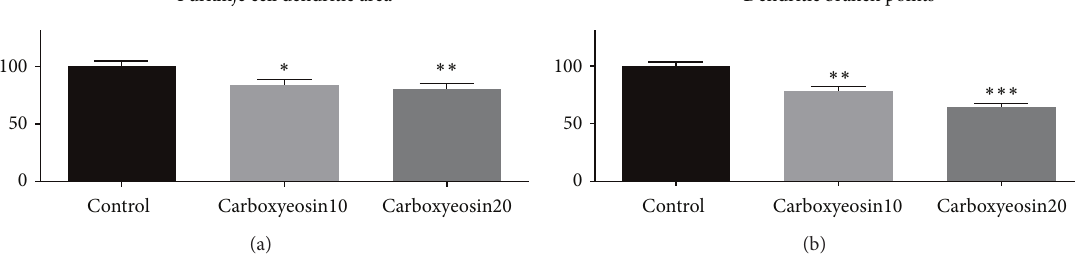
Figure 2: (a) Size of Purkinje cell dendritic arbors in control and carboxyeosin-treated cultures: The mean size of control Purkinje cells was considered as 100%. Purkinje cell dendritic trees from carboxyeosin-treated cultures were significantly smaller compared to control cultures with 𝑃 < 0.05 ( ∗ ) for 10 𝜇 M carboxyeosin and 𝑃 < 0.01 ( ∗∗ ) for treatment with 20 𝜇 M carboxyeosin. Error bars represent the SEM. (b) Number of branch points with carboxyeosin: The mean number of branch points of control Purkinje cells was considered as 100%. Carboxyeosin treatment alone showed a reduction of the number of branch points to 73% with 10 𝜇 M and 62% with 20 𝜇 M compared to controlvalues.Thesedifferencesweresignificantwith 𝑃 < 0.01 ( ∗∗ )for10 𝜇 Mcarboxyeosinandwith 𝑃 < 0.001 ( ∗∗∗ )for20 𝜇 Mcarboxyeosin. Error bars represent the